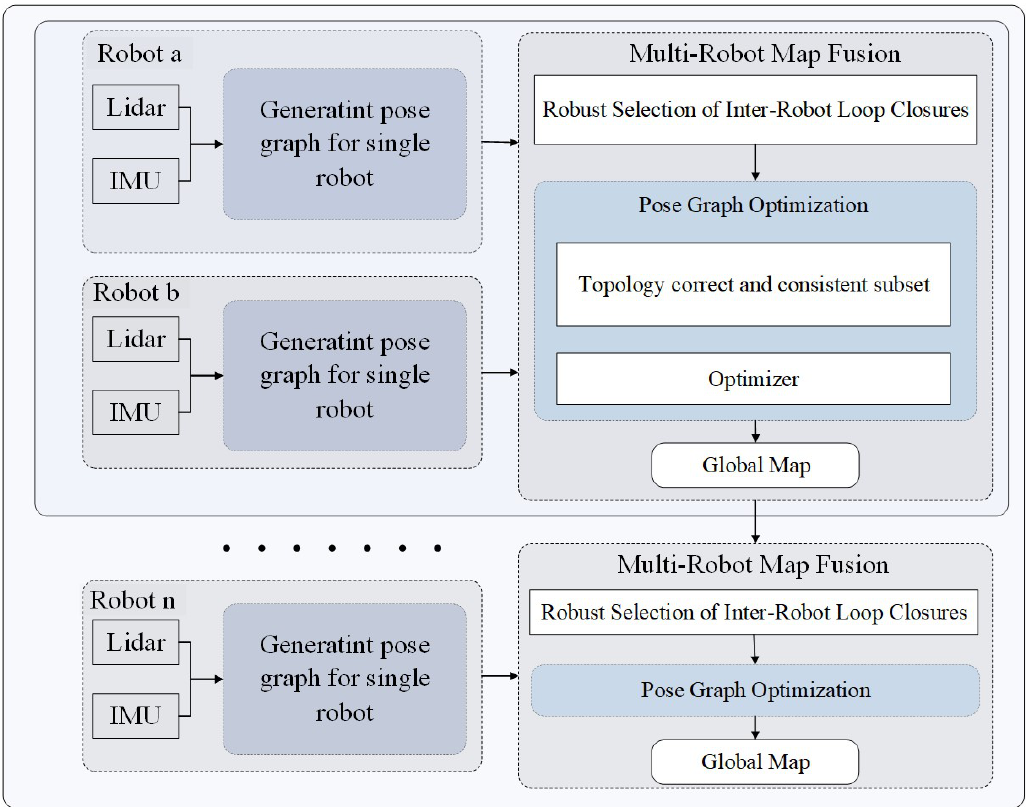
Figure 4. Diagram of system